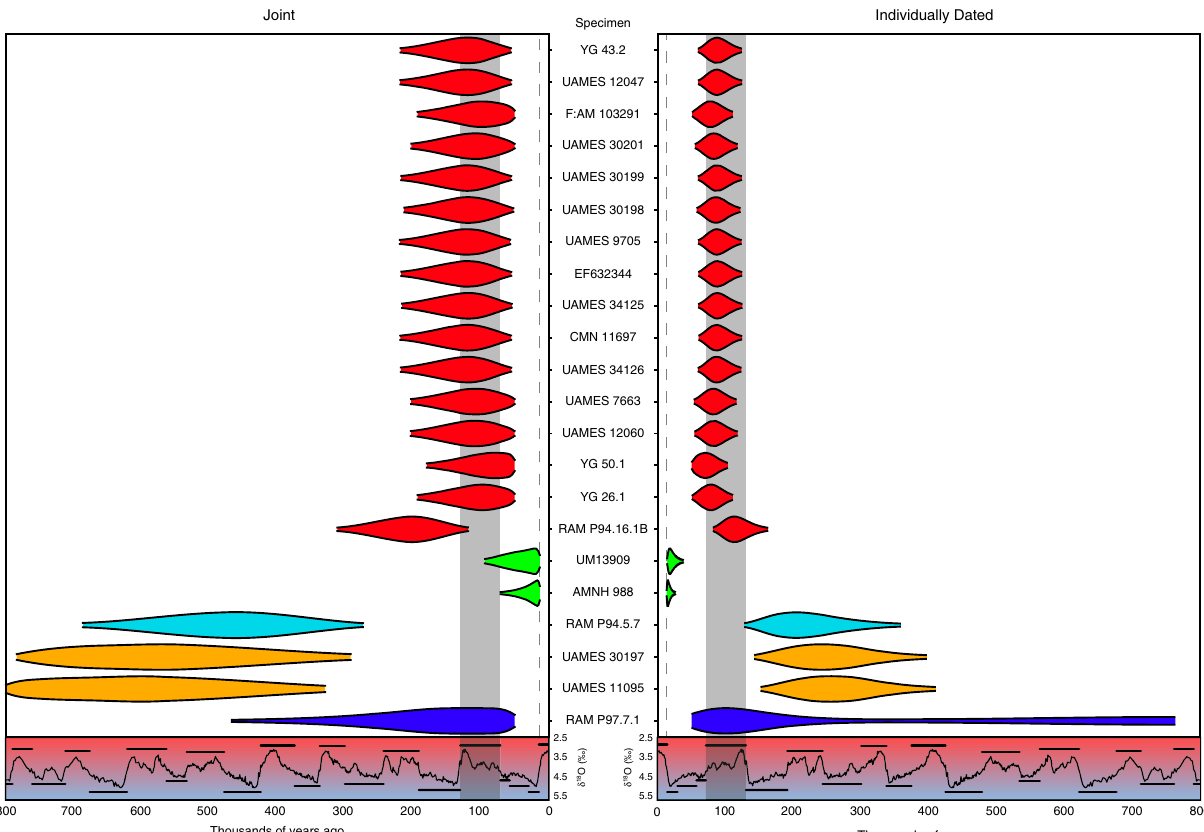
Fig. 3 Marginal posterior densities of specimen ages in molecular dating analyses. Specimens are coloured by clade and arranged as in Fig. 1b. Each violin represents the 95% HPD interval of each specimen age estimated in the Joint (left) and Individually Dated (right) analyses. The δ 18 O record for the last 800 thousand years is overlaid below both plots and corresponds to the one in Fig. 2a, with the approximate extent of the MIS 5 interglacial shaded in grey. The dashed grey line at 13 kya represents the minimum bound imposed by the youngest specimen in the